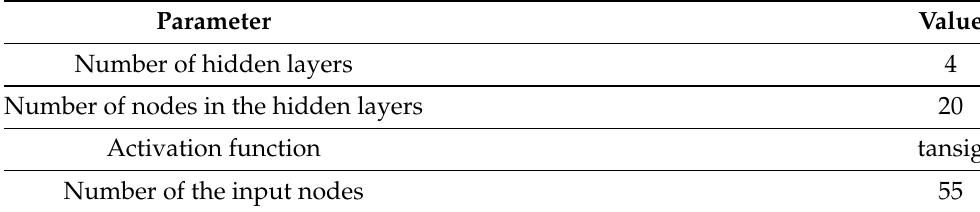
Table 8. The architecture parameters of the chosen DL